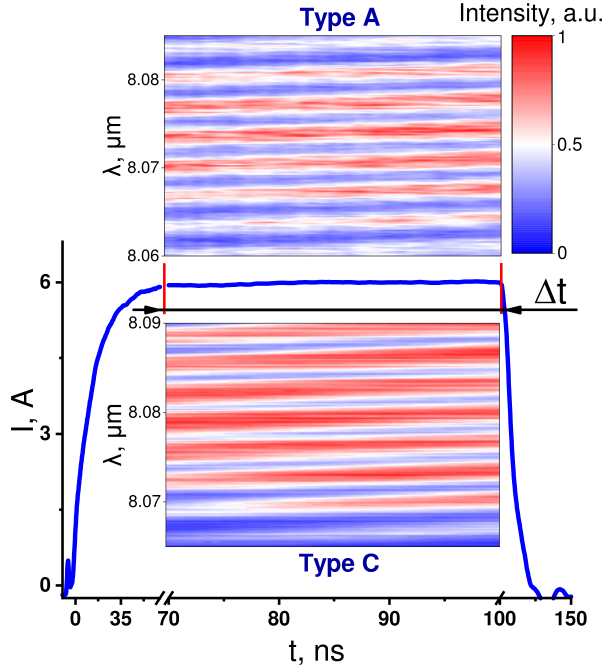
Figure 3. The measurements of the heating rate in the QCLs based on two different heterostructures: Type A with the InP-based upper cladding and contact layer (the upper colored panel) and Type C with the InP-based upper cladding and InGaAs-based contact layer (the lower colored panel). The colored panels are heatmaps that show the intensity of the Fabry–Perot modes as a function of time and wavelength. The blue curve in the middle shows the pump pulse. ∆ t is the time range during which the heating rate was measured. It corresponds to a nearly constant pumping value.